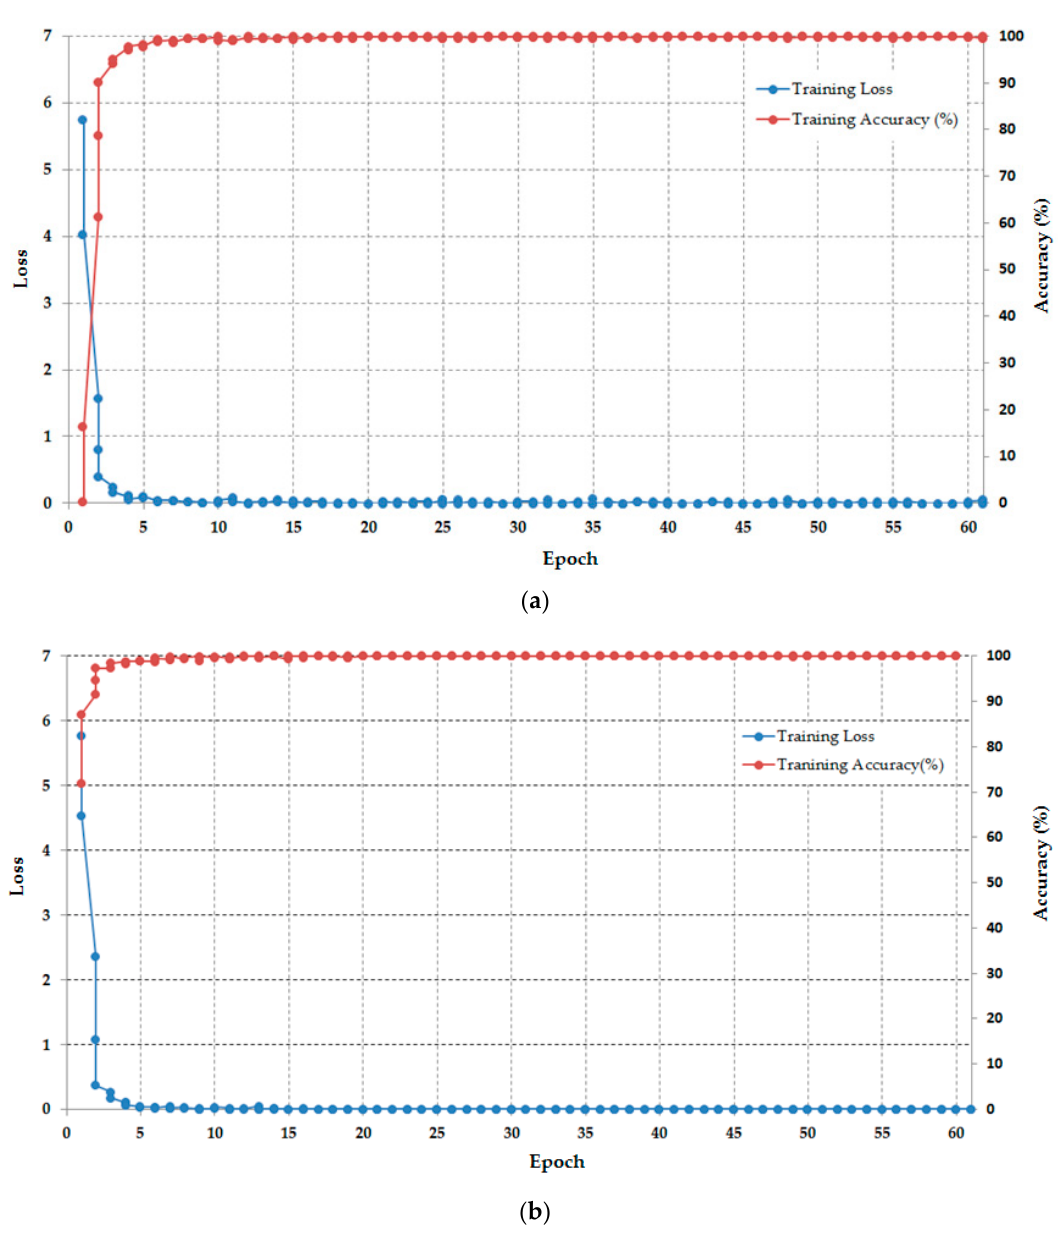
Figure 8. The average convergence graphs of CNN training from five-fold cross-validation across training epochs: ( a ) Using visible light images, and ( b ) Using thermal images.